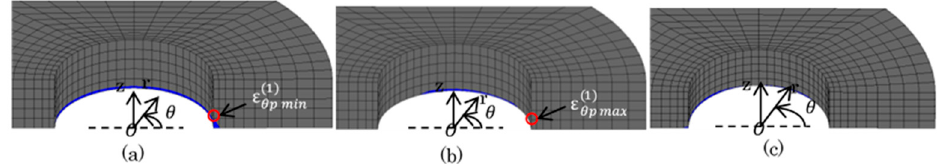
Figure 15. Plastic region of inner plate ( σ yield = 970 MPa : plastic region): ( a ) press-fitting state; ( b ) tensile state; ( c ) sprocket-engaging state.